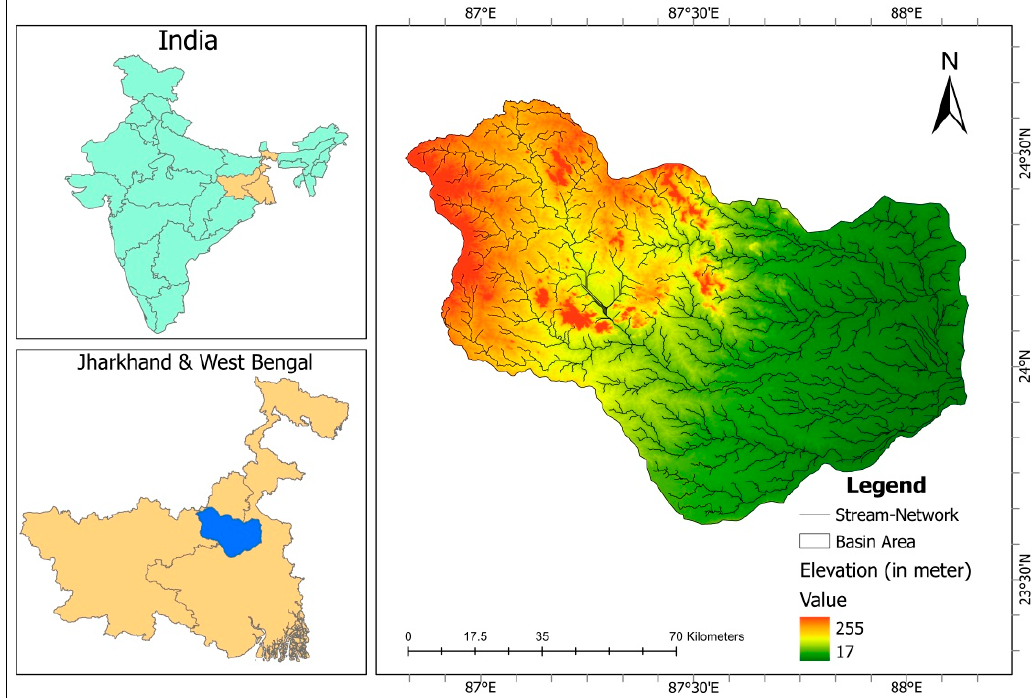
Figure 1. Location map of Mayurakshi river basin.